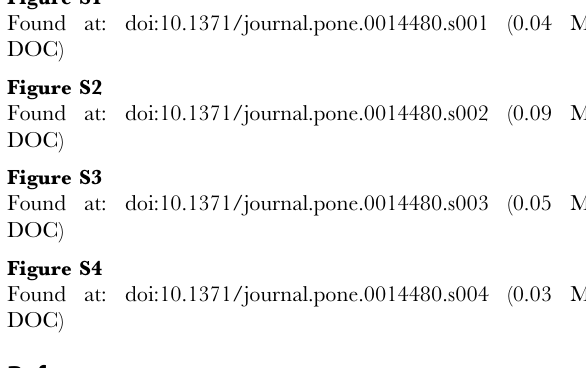
Figure S1 Found at: doi:10.1371/journal.pone.0014480.s001 (0.04 MB Figure S2 Found at: doi:10.1371/journal.pone.0014480.s002 (0.09 MB